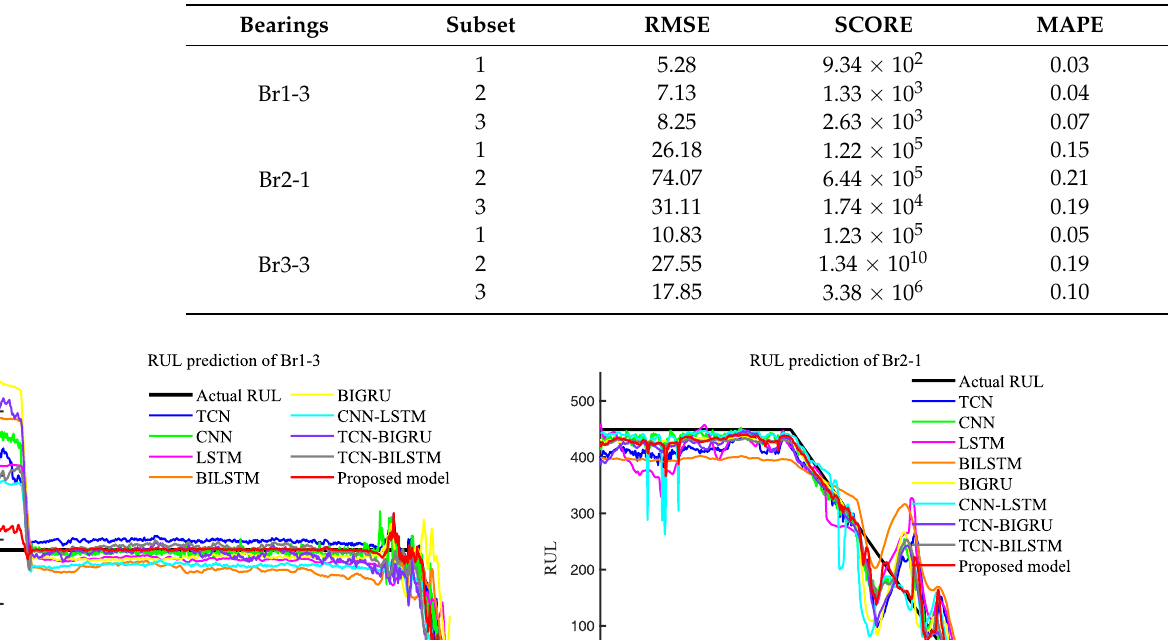
Table 6. Evaluation indexes for different feature subsets.